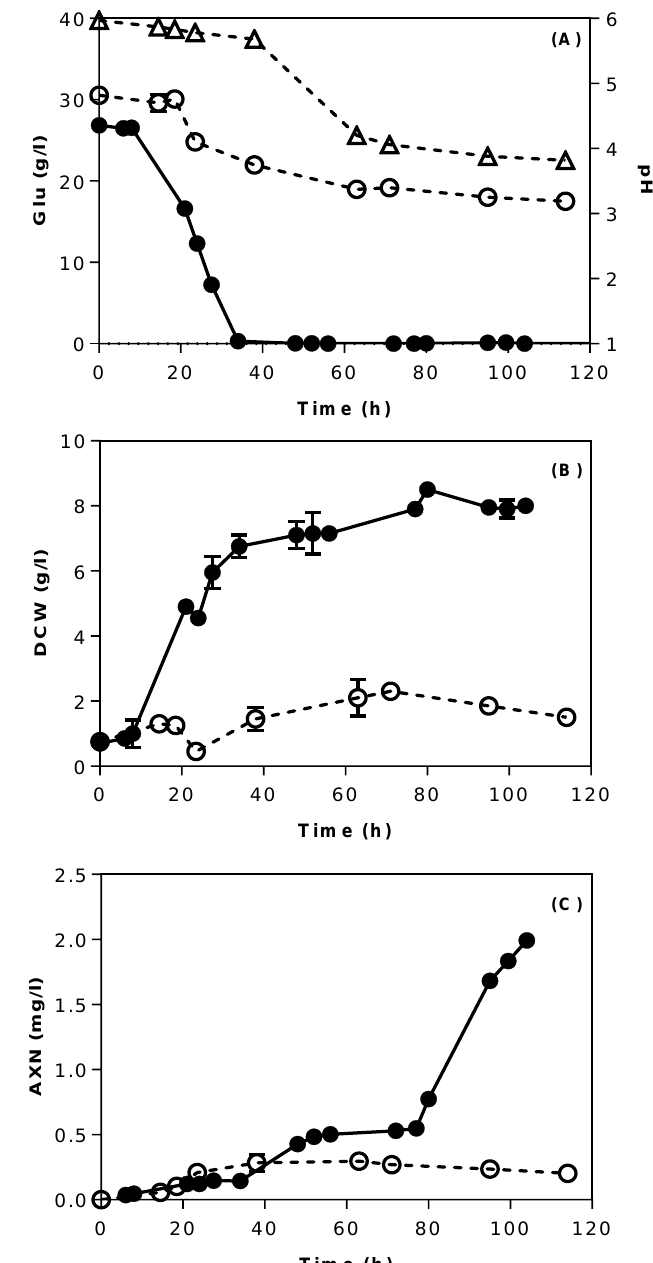
Figure 1. Profile of ( A ) glucose consumption, ( B ) growth and ( C ) astaxantin production during cultivation of X. dendrorhous in a 2-L stirred tank reactor using semi-defined media at different pH conditions. Symbols represent: (●) controlled pH 6, ( ○ ) uncontrolled pH, and (∆) pH profile for the uncontrolled experiment. Fermentation conditions; aeration, 1 L/min; temperature, 20 °C; agitation, 250 rpm. Abbreviations: AXN—astaxanthin; Glu—glucose; DWC—dry cell weight.